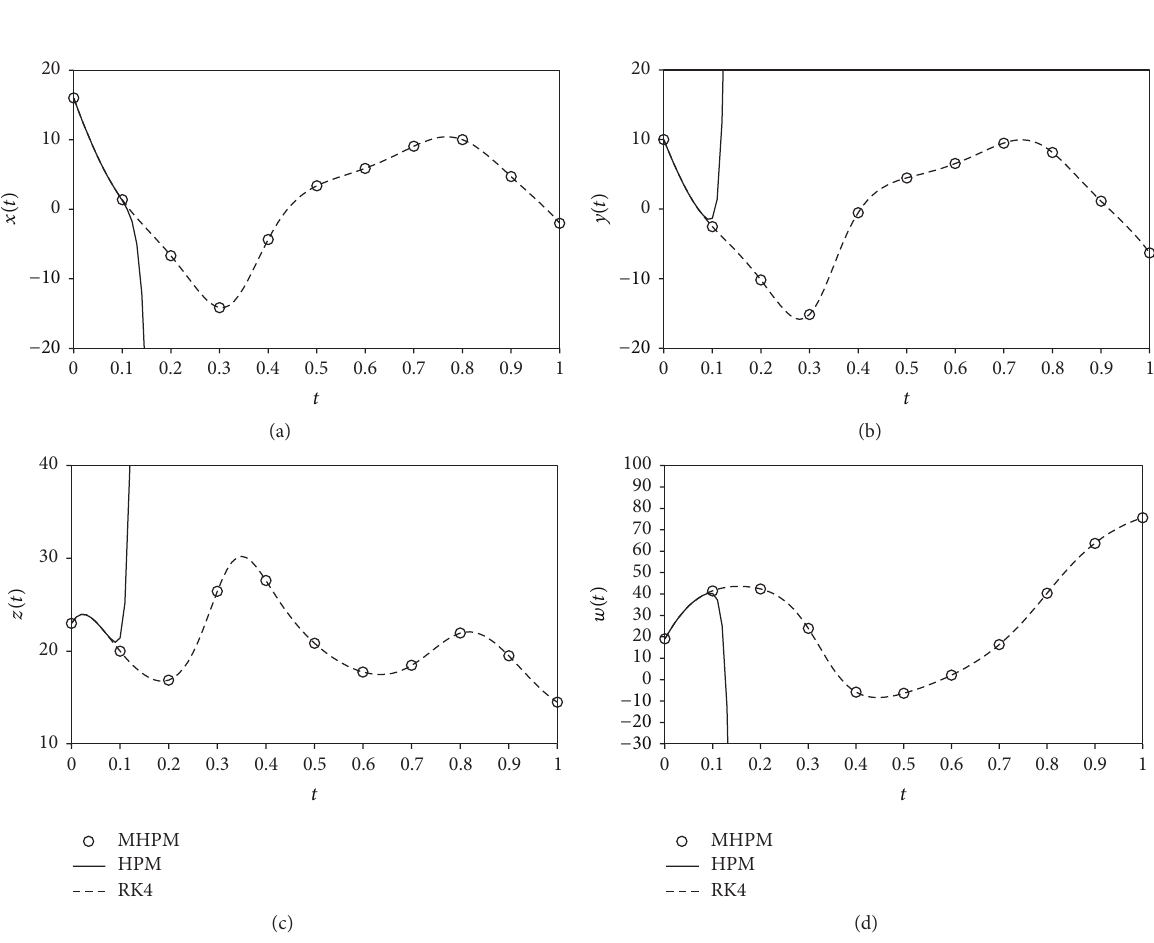
Figure 3: Comparison among 15-term HPM (solid line), MHPM (circle), and RK4 (dash line) for Case 1 of hyperchaotic L¨u system.